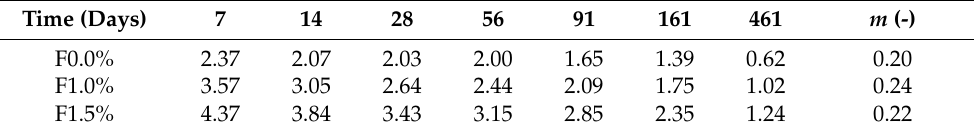
Table 4. Diffusion coefficient [m 2 s − 1 ] in time calculated based on surface resistivity measurements.